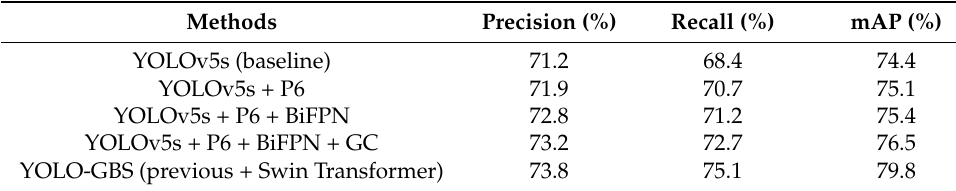
Table 1. Results of ablation